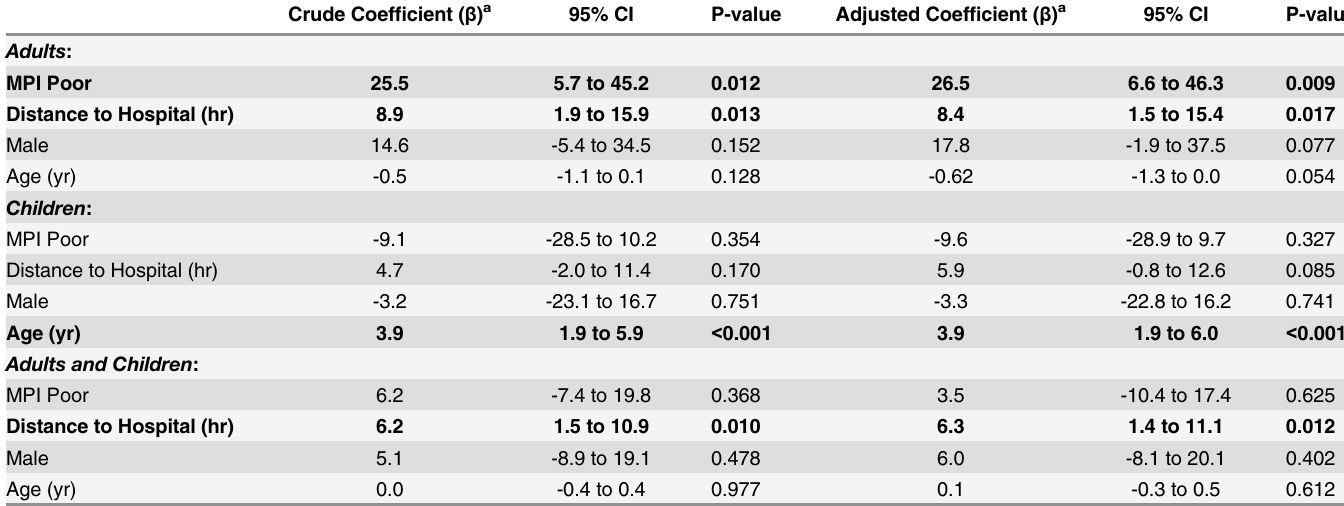
Table 5. Multiple linear regression analyses of pre-hospital illness timespan (in hours) for adults, children, and all